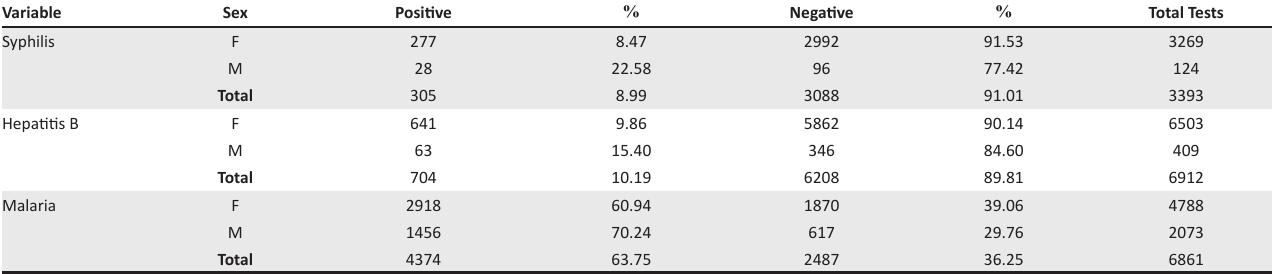
TABLE 4: Results of common tests for infectious diseases, Tontokrom, Ghana 2010–2017. Variable Sex Positive % Negative